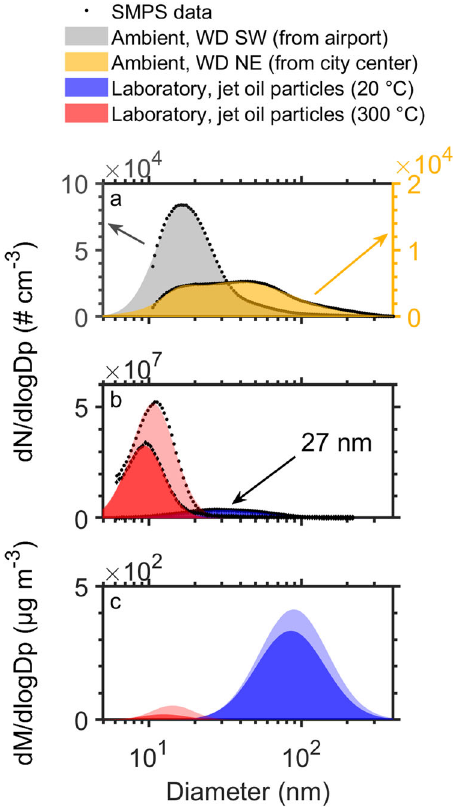
Fig. 1 Particle size distributions of ambient and laboratory-generated ultra fi ne particles. Ambient particle size distribution ( a ) at the monitoring site during wind direction (WD) from the airport (grey) and the city (yellow), averaged over three days (05:00 – 23:00 CET). Number-size ( b ) and mass-size distribution ( c ) from two laboratory experiments, each with jet oil nanoparticles generated from a methanolic solution, native at 20 °C (blue & light blue) and after heating to 300 °C (red & light red). Measurement data (black dots) were fi tted using a lognormal